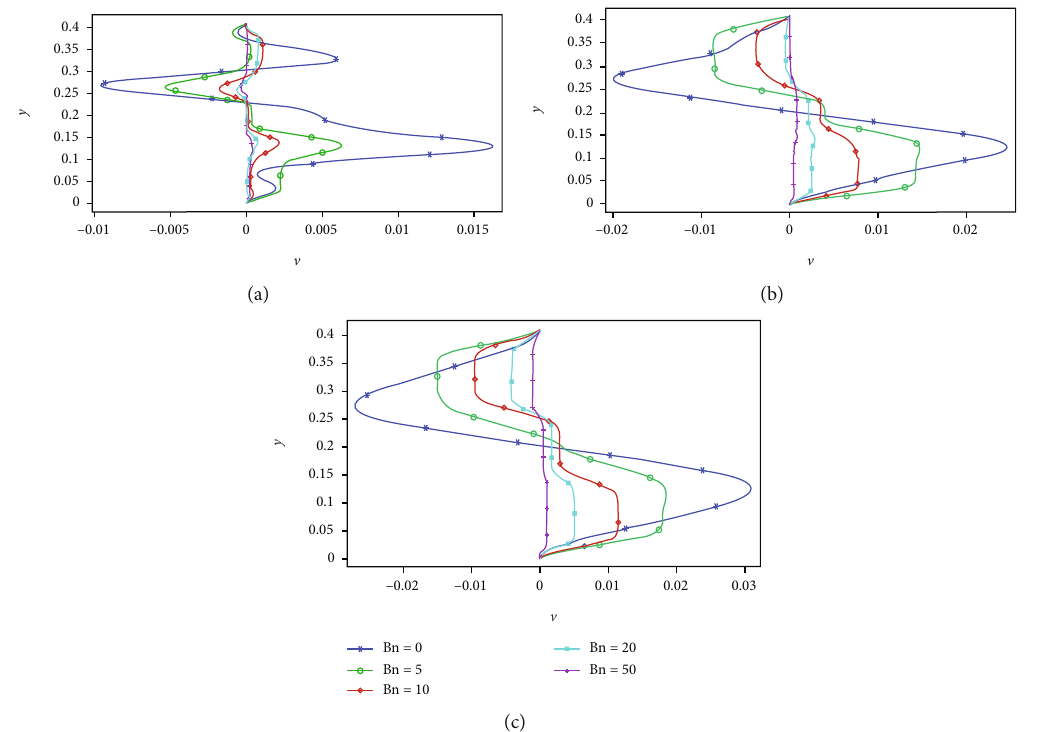
Figure 13: Impact on v velocity for di ff erent Bn . (a) Gp = 0 : 1 m , x = 0 : 3 m . (b) Gp = 0 : 2 m , x = 0 : 35 m . (c) Gp = 0 : 3 m , x = 0 : 4 m .